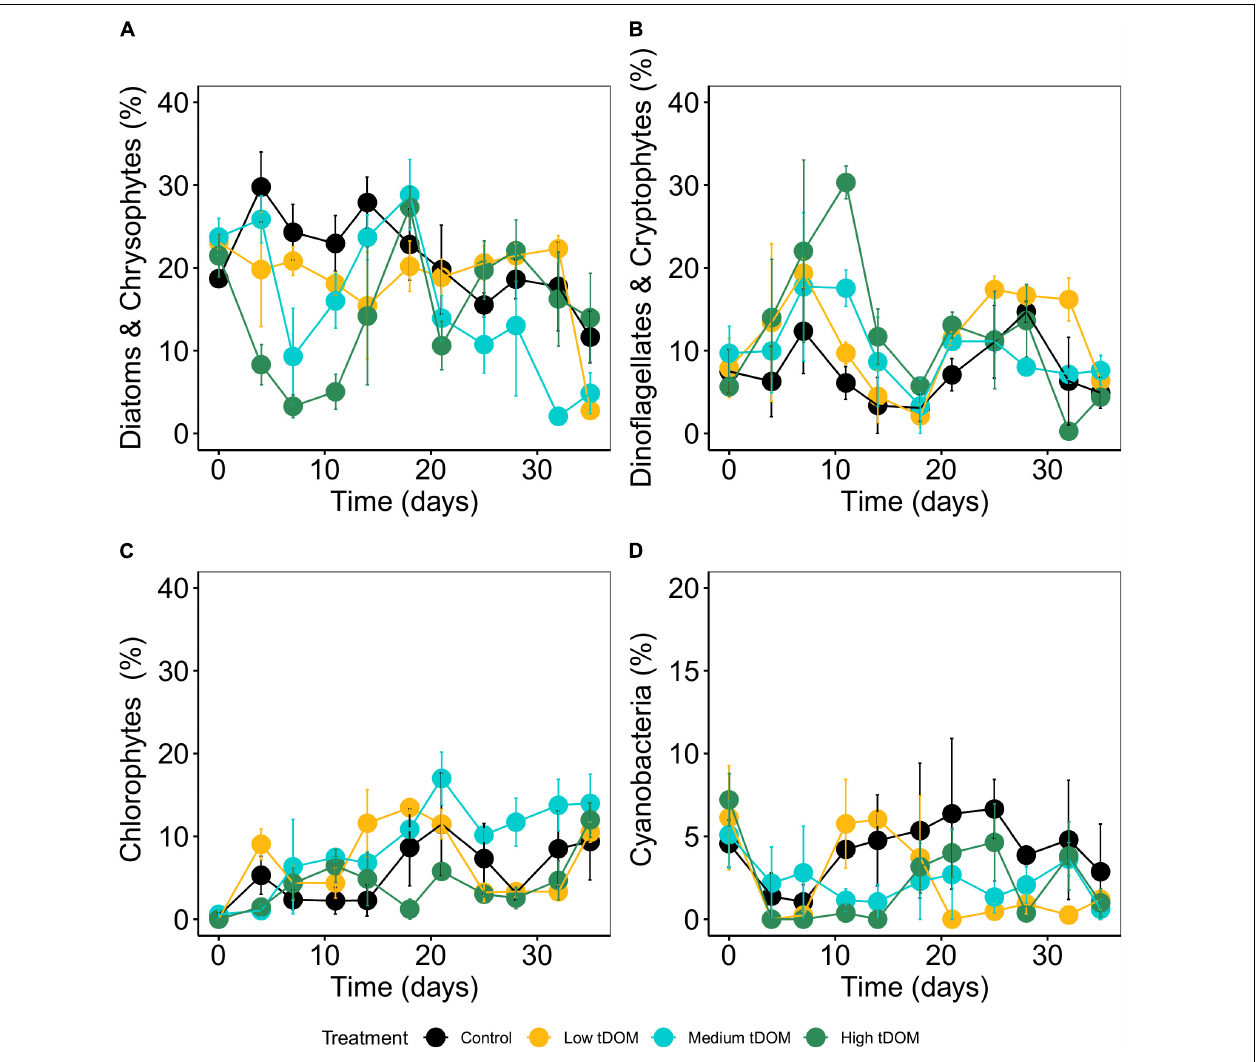
FIGURE 4 | Relative abundance of phytoplankton (%) specific pigment signature compositions over 35 days of the experiment. (A) Diatom and chrysophytes, (B) dinoflagellates and cryptophytes, (C) chlorophytes and (D) cyanobacteria. Error bars represent standard deviation. Color plots represent tDOM addition in the control (black), low tDOM (yellow), medium tDOM (blue), and high tDOM (green)